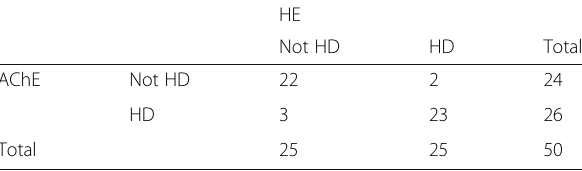
Table 2 Comparison of the diagnosis of HD using calretinin